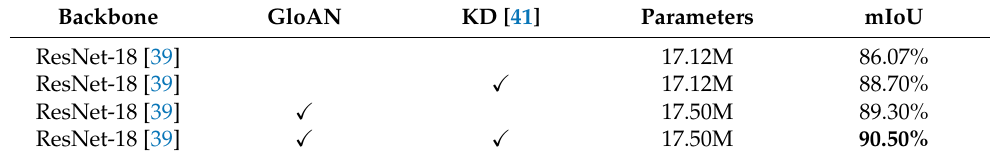
Table 3. Rice lodging segmentation based on DeepLabv3+. KD denotes knowledge distillation.